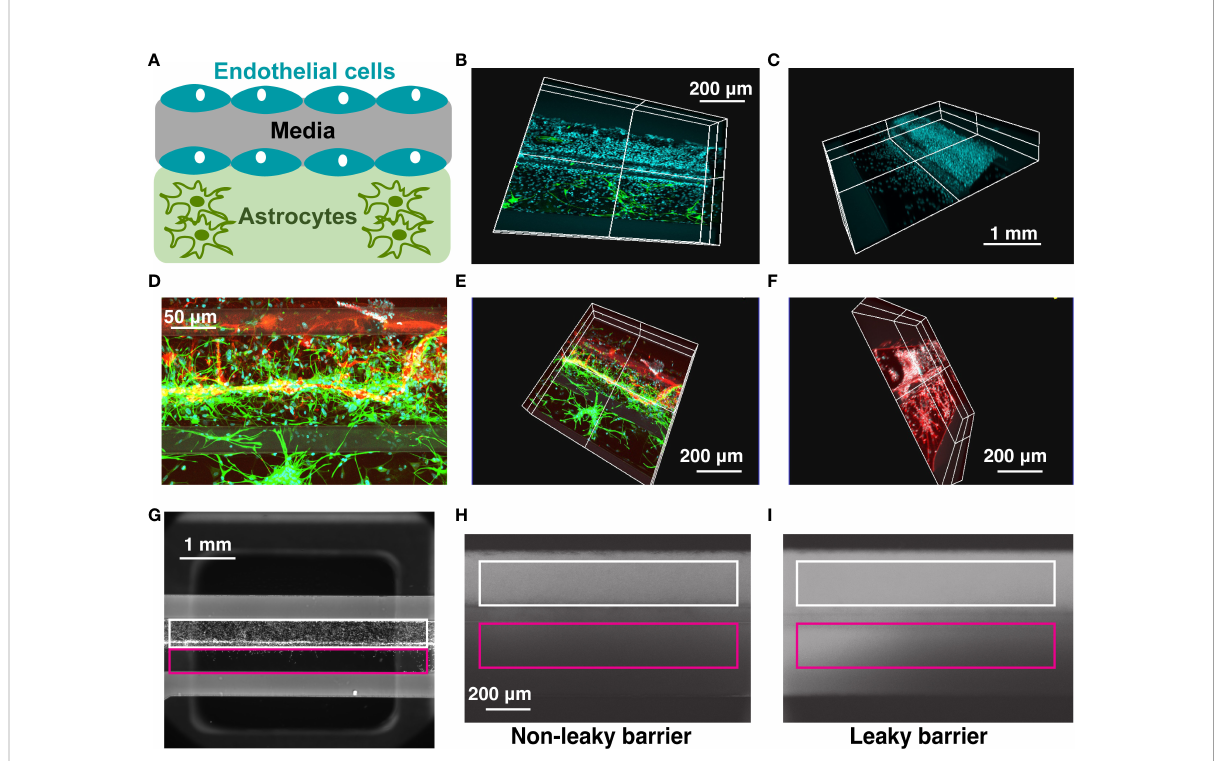
FIGURE 1 OrganoPlate blood-brain barrier model. (A) Schematic representation of cells seeded in 2-lane OrganoPlate. Top lane, endothelial cells. Bottom lane, astrocytes. (B – F) . Representative images of OrganoPlates seeded with astrocytes and endothelial cells 10 days after plating. (B) Cyan, DAPI + endothelial cell nuclei in the top lane. Green, GFAP + astrocytes in the bottom lane. (C) Cyan, DAPI + endothelial cell nuclei. (D, E). Red, PECAM + endothelial cells in the top lane. Green, GFAP + astrocytes in the bottom lane. (F) White, DAPI + endothelial cell nuclei in the top lane. Red, GFAP + astrocytes in the bottom lane. (G – I) . Representative images of a 2-lane OrganoPlate chip seeded with endothelial cells in the top lane (left), a chip with a non-leaky barrier (middle) and a chip with a leaky barrier (right) loaded with a fl uorophore-conjugated dextran. White,